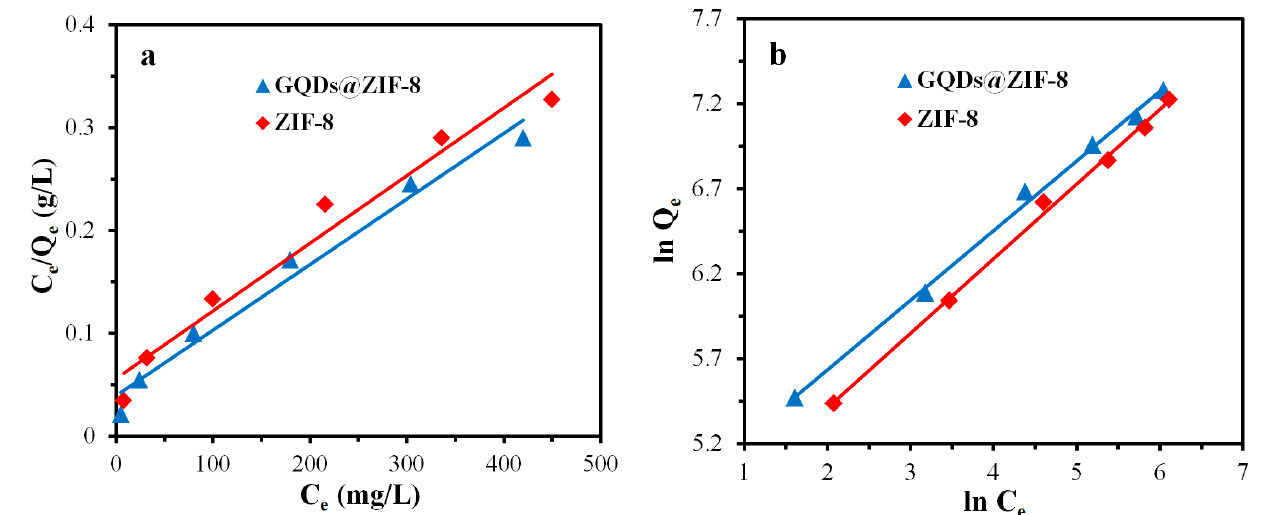
Figure 16. Langmuir model ( a ), Freundlich model ( b ) fitting curves of ZIF-8 and GQDs@ZIF-8 for ethyl acetate adsorption. Table 4. Calculated equilibrium constants of the isotherm model for toluene adsorption.